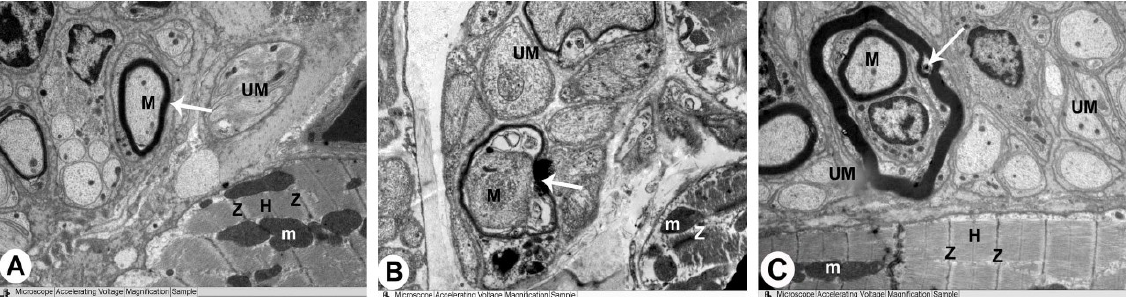
Figure 6. The right atrium is imaged using TEM in all groups of rats (nerve endings): (×10,000). ( A ) Control rat’s group displaying normally myelinated (M) containing intact myelin and unmyelinated (UM) nerve fibres in the interstitial area between intact myofilaments (Z and H) and mitochondria (m) and their striped appearance with obvious bands. ( B ) QP-treated rat’s group exhibiting pleomorphic myelinated (M) nerve fibres with disrupted myelin (arrow) and unmyelinated (UM) nerve fibres in the interstitium among apoptotic myofilaments. ( C ) QP + Vit C-treated group showing preserved myelinated (M) nerve fibres with intact myelin (arrow) and unmyelinated (UM) nerve fibres in the interstitial area.